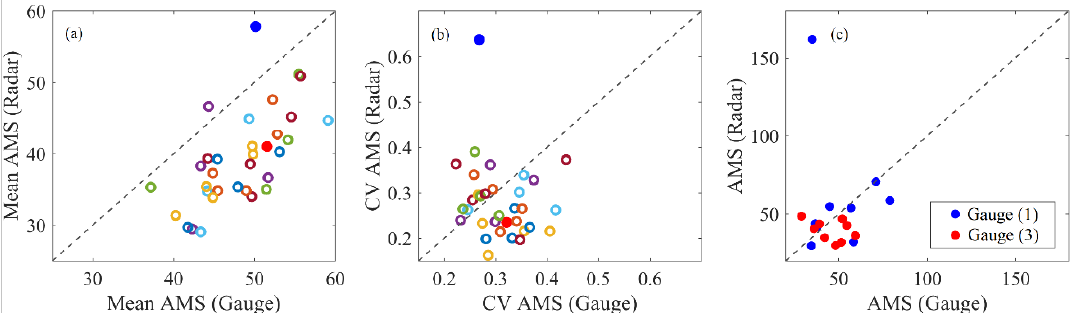
Figure 6. ( a ) the mean annual maxima rainfall depth extracted from NOAA Atlas 14 gauges and the corresponding radar-pixel (each color represents one of the 33 gauges in Louisiana retrieved from NOAA HDSC web-based data server). ( b ) same as ( a ) but reporting the coefficient of variation. ( c ) comparison of AMS from gauge data and radar-based estimates (for common period 2002–2010) at the location of two example NOAA Atlas-14 gauges (indicated in Figure 1a).